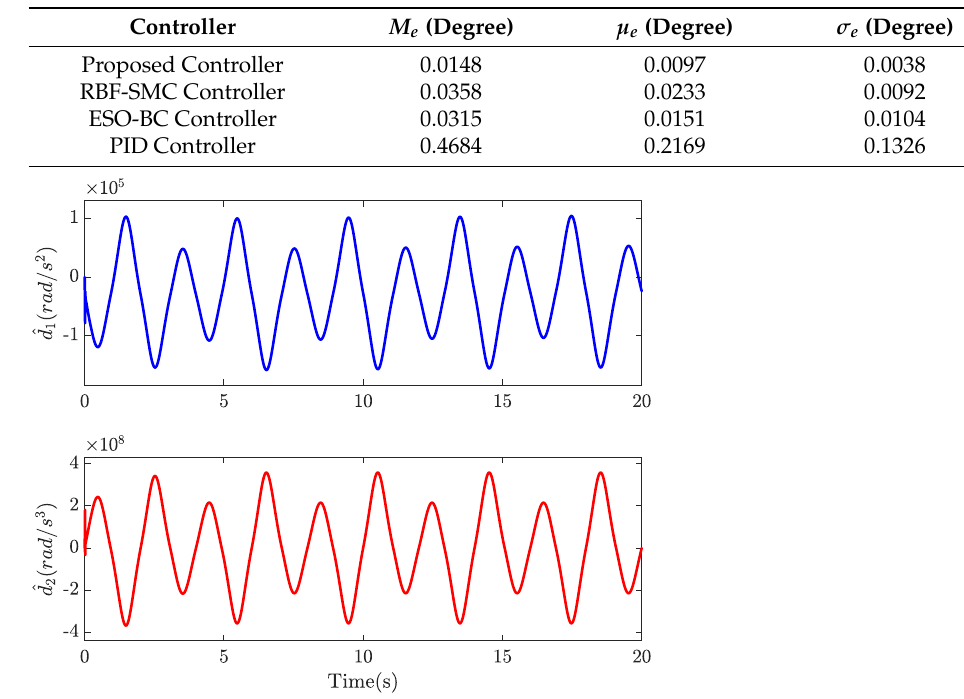
Table 3. Performance indexes in slow-motion reference trajectory of all considered controllers